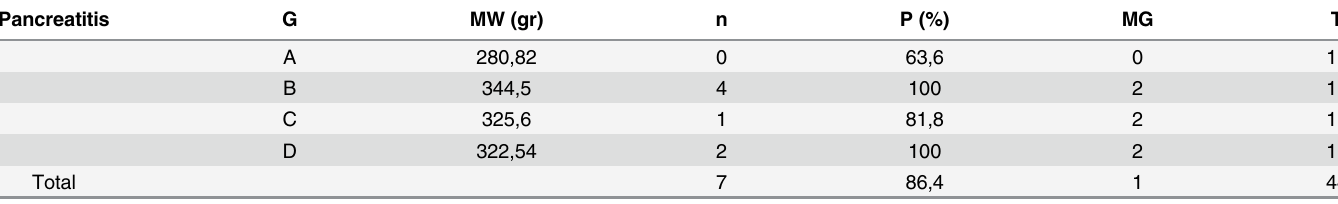
Table 3. Distribution of the grades of pancreatitis among the four groups.